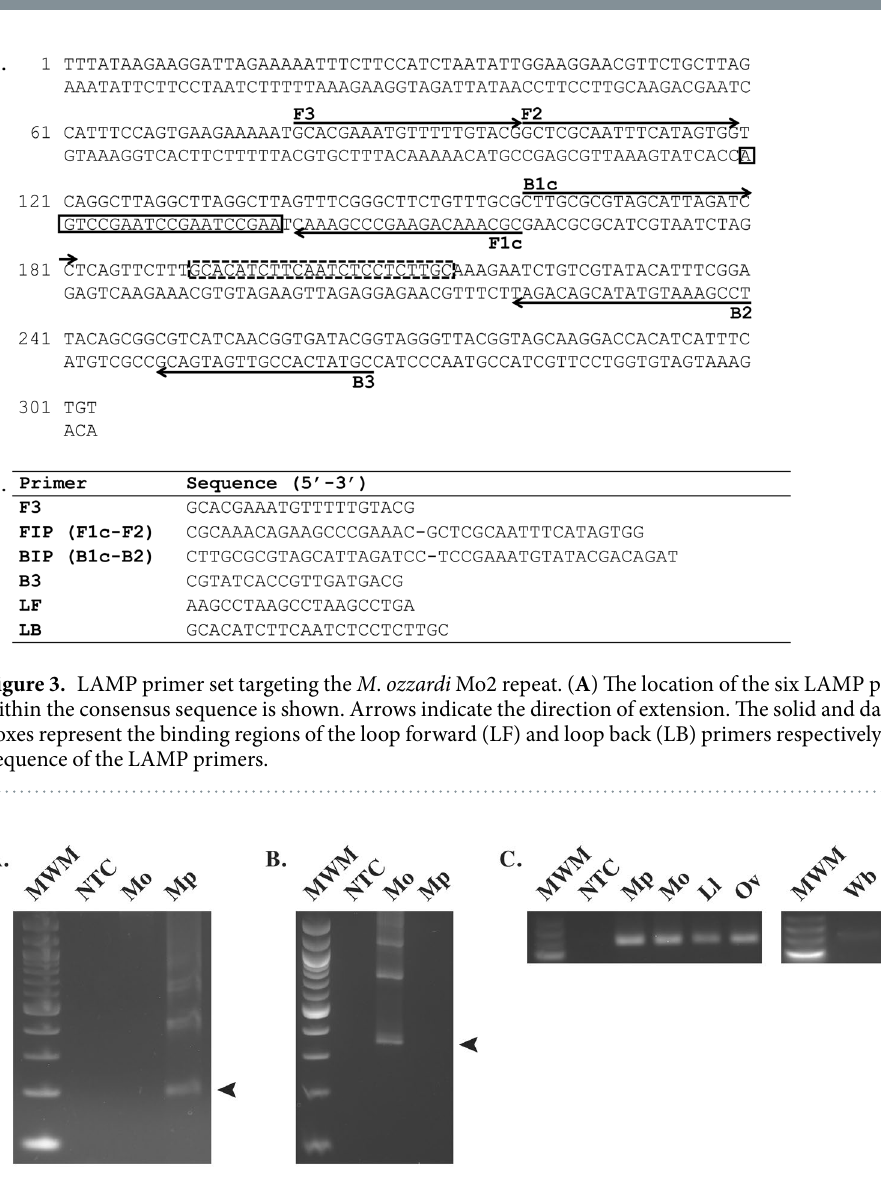
Figure 4. Genomic organization of the Mansonella target repeats. Agarose gels showing PCR amplification of the M . perstans ( A ) and M . ozzardi ( B ) repeats. A 100 bp DNA ladder (New England Biolabs) was used as the molecular weight marker (MWM). Arrows denote the monomer band of each ladder ( M . perstans , ~200 bp; M . ozzardi , ~300 bp). As a positive control for the presence of DNA ( C ), a conserved 244 bp actin fragment was PCR amplified from M . perstans (Mp), M . ozzardi (Mo), L . loa (Ll), O . volvulus (Ov) or W . bancrofti (Wb) DNA. Full-length gels for ( C ) are presented in Supplementary Fig. 4. The low molecular weight DNA ladder (New England Biolabs) was used as the molecular weight marker (MWM). Water was substituted for DNA in the non- template controls